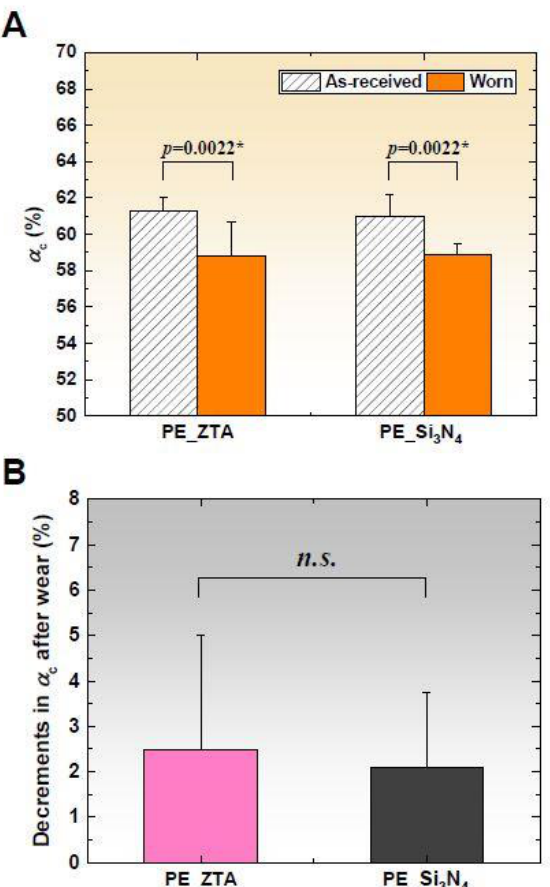
Figure 3. ( A ) Comparison of surface crystallinity ( α c ) of Vit-E XLPE acetabular liners coupled with ZTA and Si 3 N 4 before and after 5 Mc wear simulation; and ( B ) comparison of decrements in α c after wear. The asterisks and n.s. (not statistically significant) represent p < 0.05 and p > 0.05, respectively.